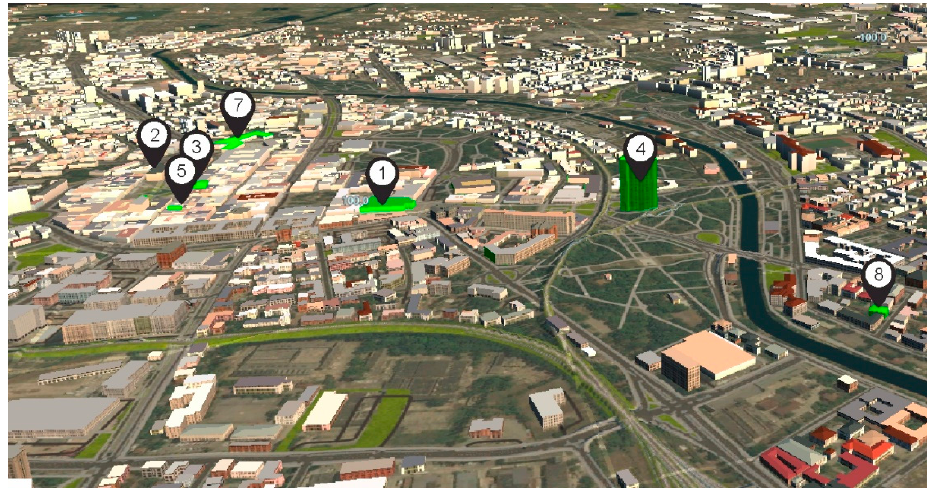
Figure 5. A visual model of Timisoara showing the buildings that young people find attractive and interesting.